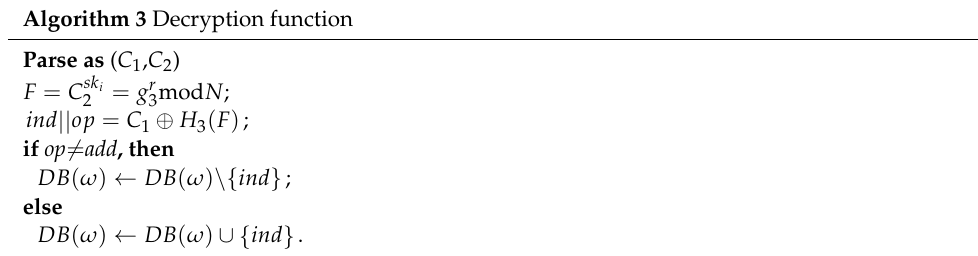
Algorithm 3 Decryption